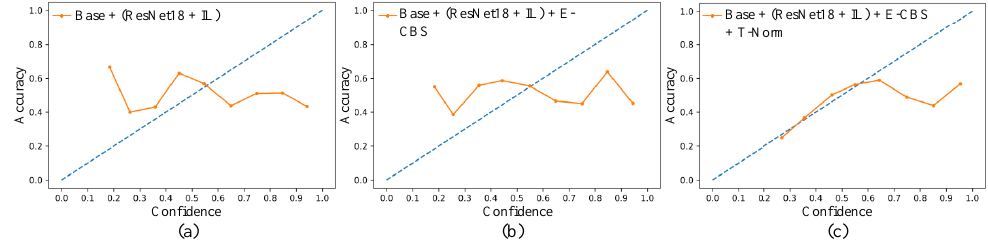
Figure 3. Reliability diagram: ( a ) Base + (ResNet18 [13] + IL [12]), ( b ) Base + (ResNet18 [13] + IL [12])